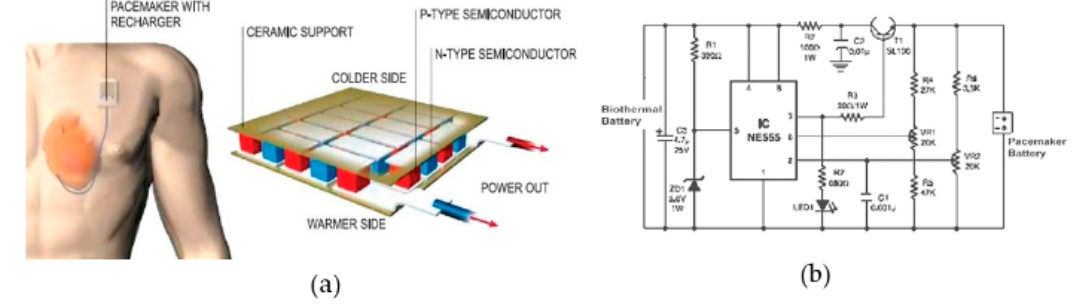
Figure 18. ( a ) P-N junction array for pacemaker; ( b ) battery charging circuit [98].